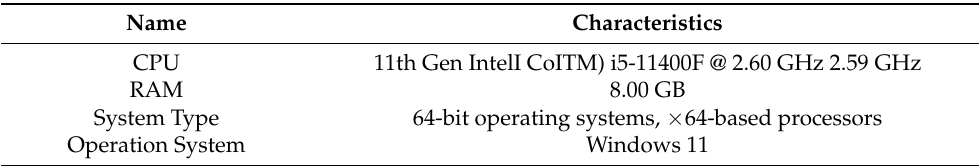
Table 3. Computer Characteristics.